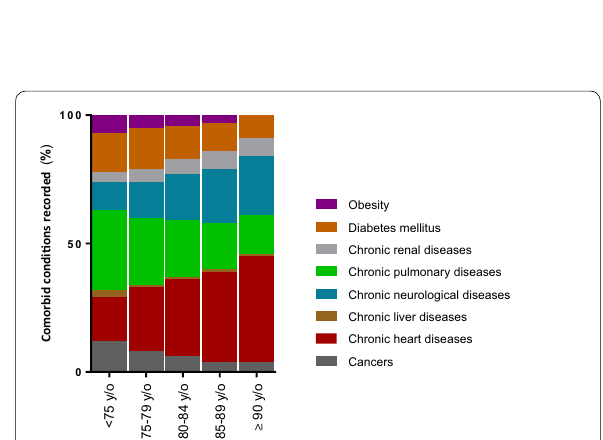
Fig. 4 Frequency of comorbid conditions by age class. Frequency of comorbid conditions are represented for each age class. We calculated the percentage of each code on the total number of coded comorbidities recorded. We plotted the result using stacked bar graphs for each age class, with the total bar height representing 100% of comorbidity